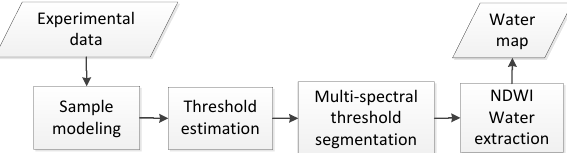
Figure 7. The overall flow chart of the proposed MST-NDWI water extraction